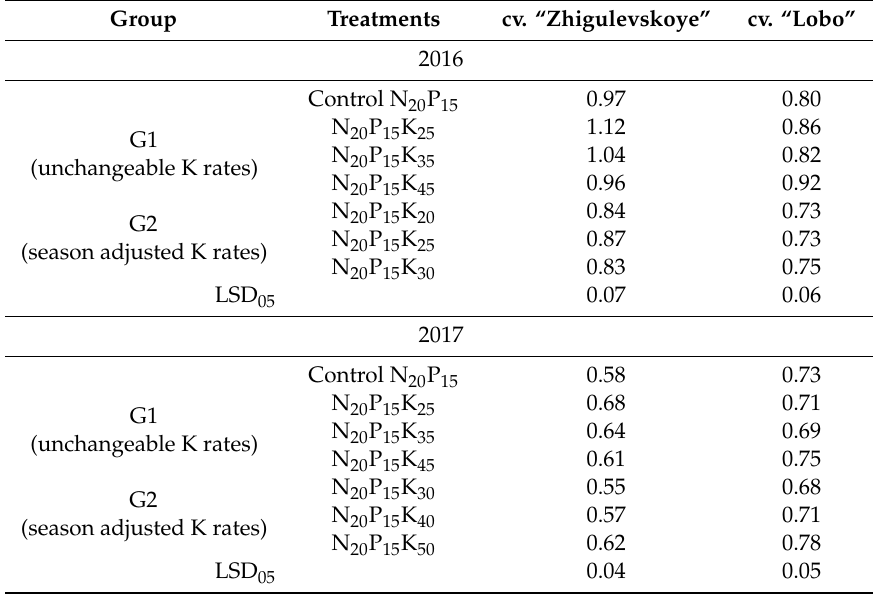
Table 15. The e ff ect of di ff erent potassium fertilization rates and fertigation approaches on the potassium content in apple fruits, %